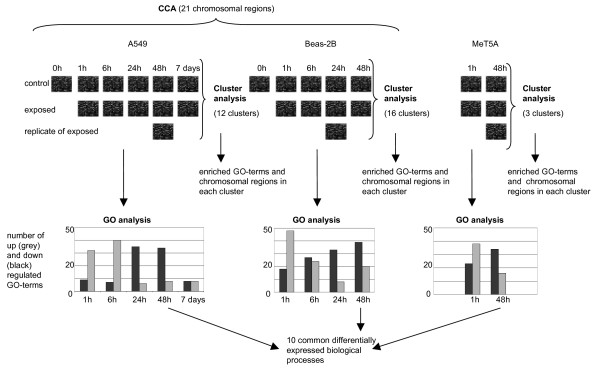
Overall study design.